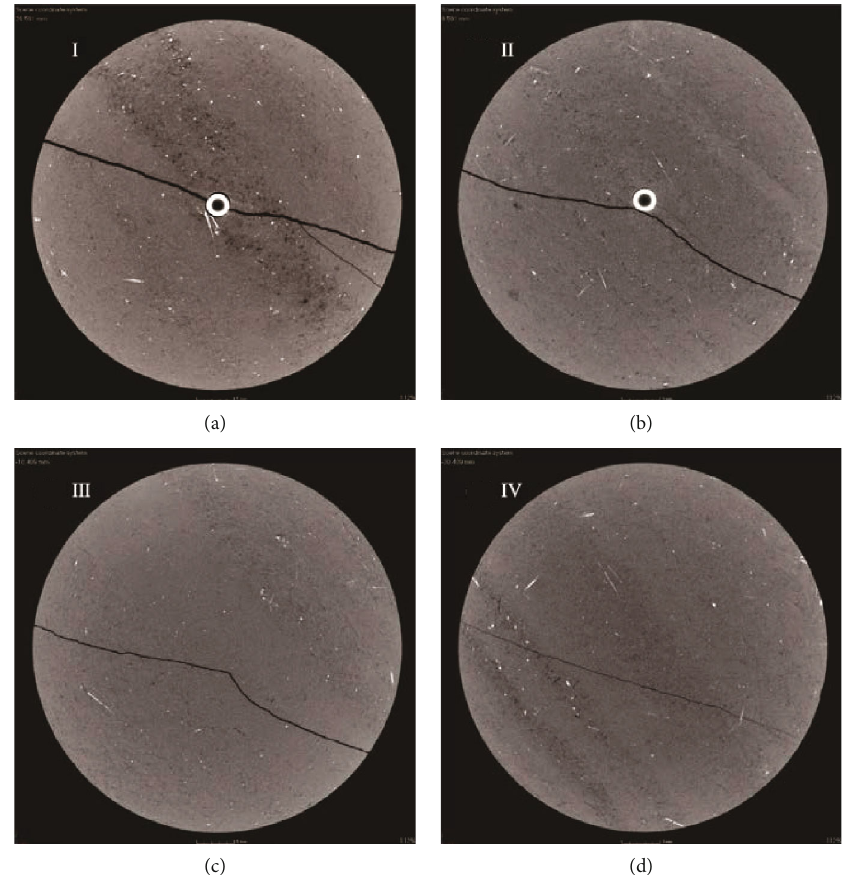
Figure 10: Four horizontal slices of the micro-CT scanning results of rock sample T2. (a – d) Correspond to the horizontal slices at heights of 20mm, 40mm, 60 mm, and 80mm, respectively.